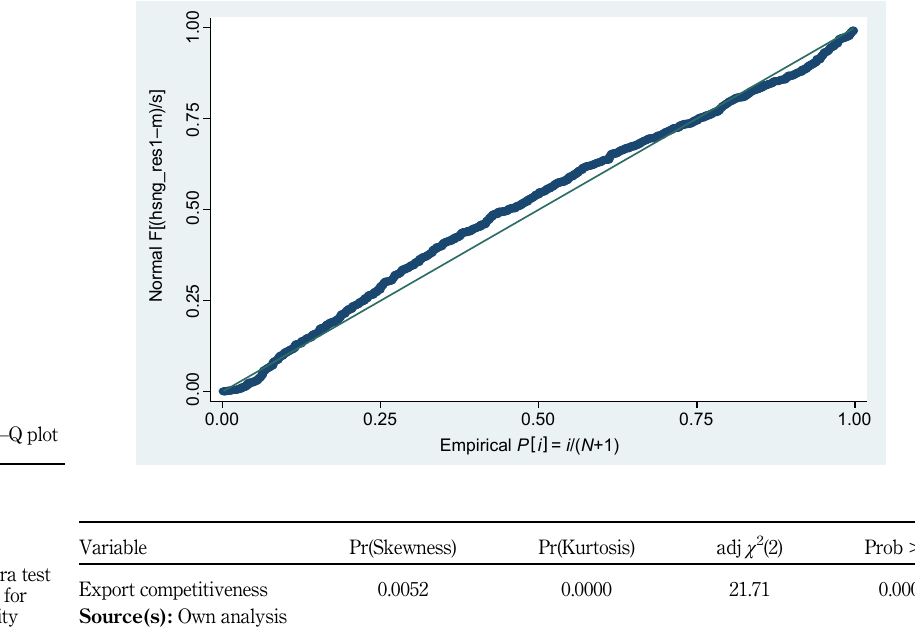
Table 1. The Jarque – Bera test its competitors for testing